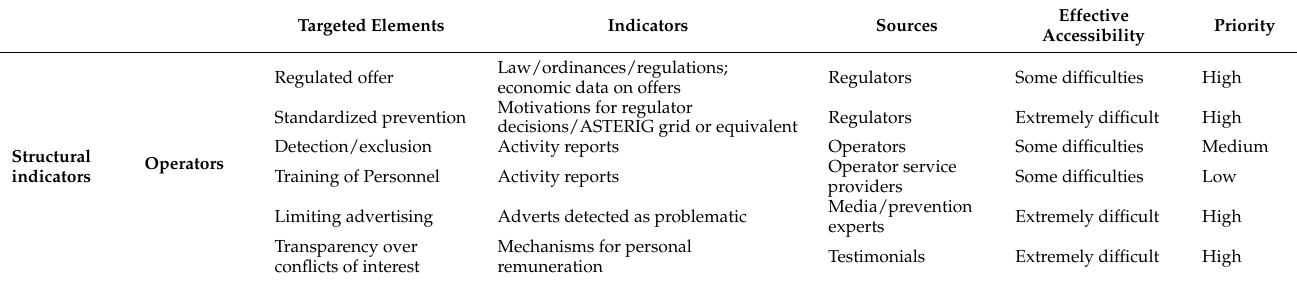
Figure 1. First conceptualization of an impact model. Table 2. A current understanding of identified monitoring